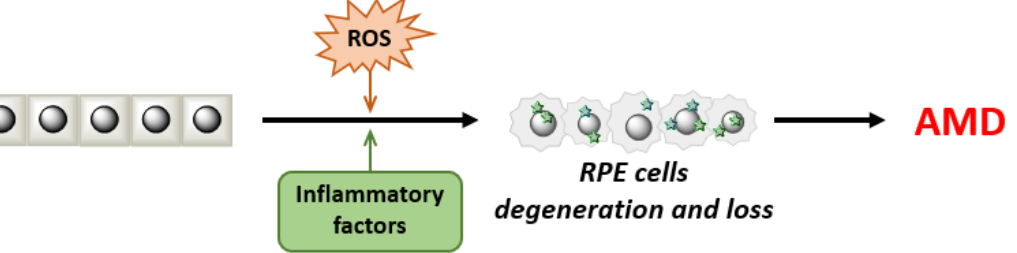
Figure 14. AMD progression due to ROS and inflammatory factors.